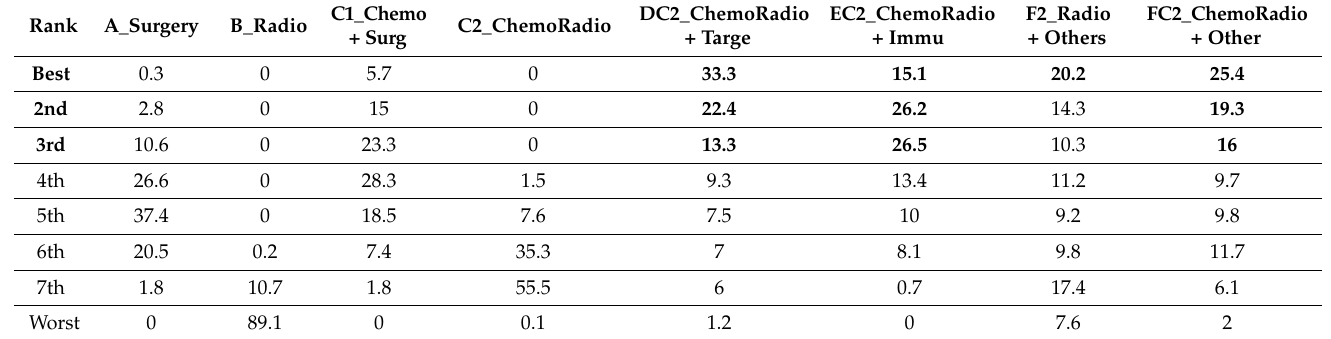
Figure 5. Network map of response rate/disease-free control rate (non-advanced stage).